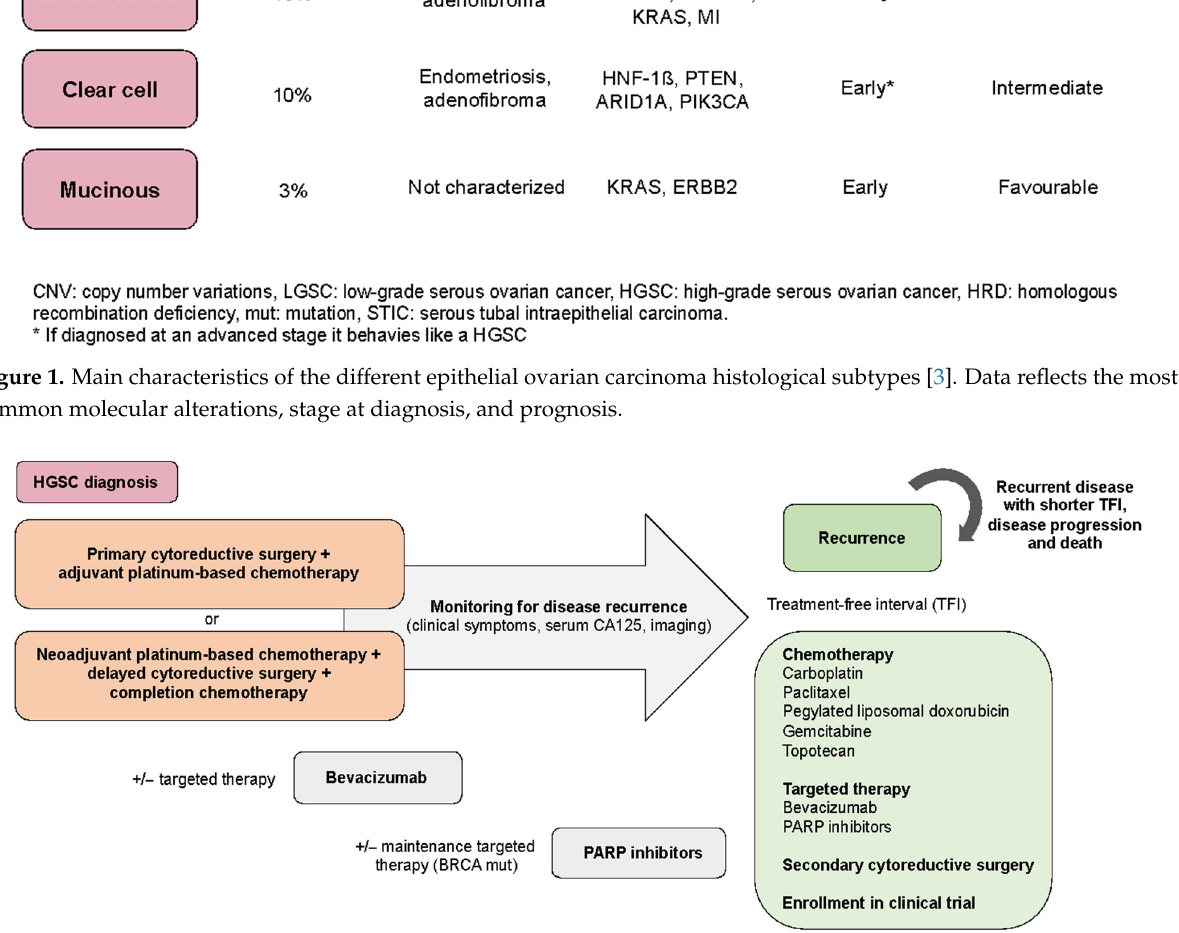
Figure 2. Clinical management of high-grade serous ovarian cancer at diagnosis and at the time of disease recurrence. Despite effective treatment, ~75% of women with HGSC will develop recurrence and ultimately succumb to their disease [4]. Although most recurrent HGSCs will initially re- spond to second-line chemotherapy, response rates diminish substantially with subse- quent lines of treatment, and eventually, the disease will become resistant. The most widely used and accepted clinical surrogate of chemotherapy response is the treatment- free interval (TFI). The TFI is also used for the selection and stratification of patients for clinical trials [22]. Tumors considered to be sensitive to chemotherapy, usually based on a TFI above 6 months, can benefit from the re-use of a platinum-based doublet regimen. Various combination therapies are being used in this setting including carboplatin with paclitaxel, pegylated liposomal doxorubicin, gemcitabine, bevacizumab, or trabectedin [23–25]. In addition, maintenance therapy with PARP inhibitors is also being used in BRCA mutated and homologous recombination deficient (HRD) tumors. Tumors that are resistant to first-line chemotherapy (~15%) have a poor prognosis. Due to the short ex- pected survival, usually less than 12 months, treatment is focused on quality of life and control of symptoms. Several agents including gemcitabine, weekly paclitaxel, bevaci- zumab, pegylated liposomal doxorubicin, and topotecan can be used as second-line treat- ment in these patients with modest responses [26,27]. Secondary cytoreductive surgery can be considered for patients with long TFI with a recurrence that is limited and isolated. Results from the AGO DESKTOP III study demonstrated improved progression-free sur- vival (PFS), OS and a longer time to first subsequent therapy in patients with first recur- rence undergoing secondary cytoreductive surgery with complete tumor resection [28]. Monitoring of disease recurrence is usually performed by clinical examination, im- aging techniques, and serum CA125 levels. However, the use of these examinations is widely variable amongst different gynecological oncology society guidelines. Increasing levels of CA125 are generally not sufficient to initiate treatment unless a patient is symp- tomatic or is enrolling in a clinical trial. In addition, some patients with recurrence may not present with increased levels of CA125. Alternative markers such as HE4 are also be- ing evaluated for the monitoring of disease recurrence and progression [29]. There are currently no markers approved in the clinic for the prediction of treatment response and the prognosis of HGSC (Table 1) [30].